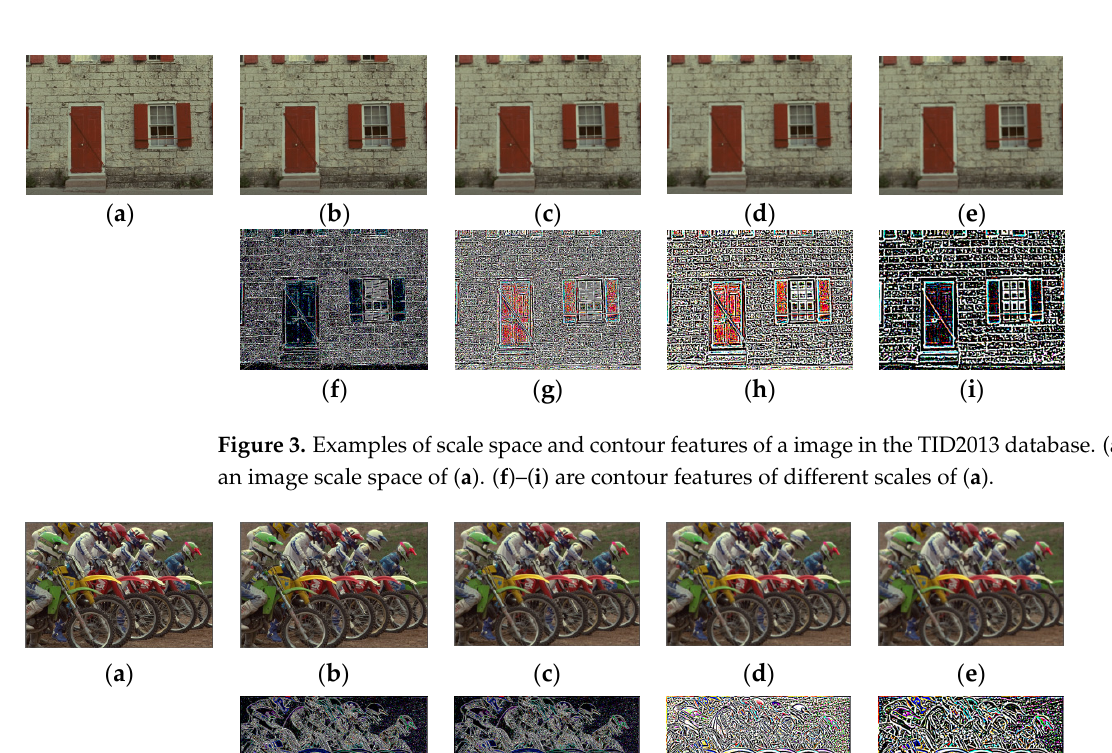
Figure 2. The generation of the multi-scale contour features.